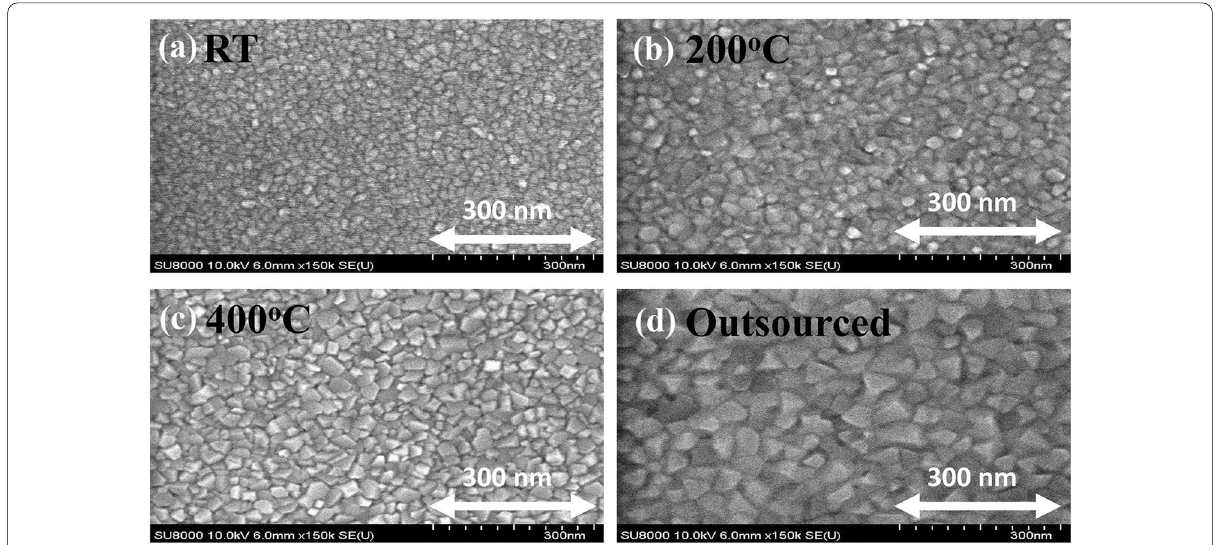
Fig. 2 Surface SEM images of Pt films with various deposition temperatures as a room temperature, b 200 °C, c 400 °C, and d outsourced